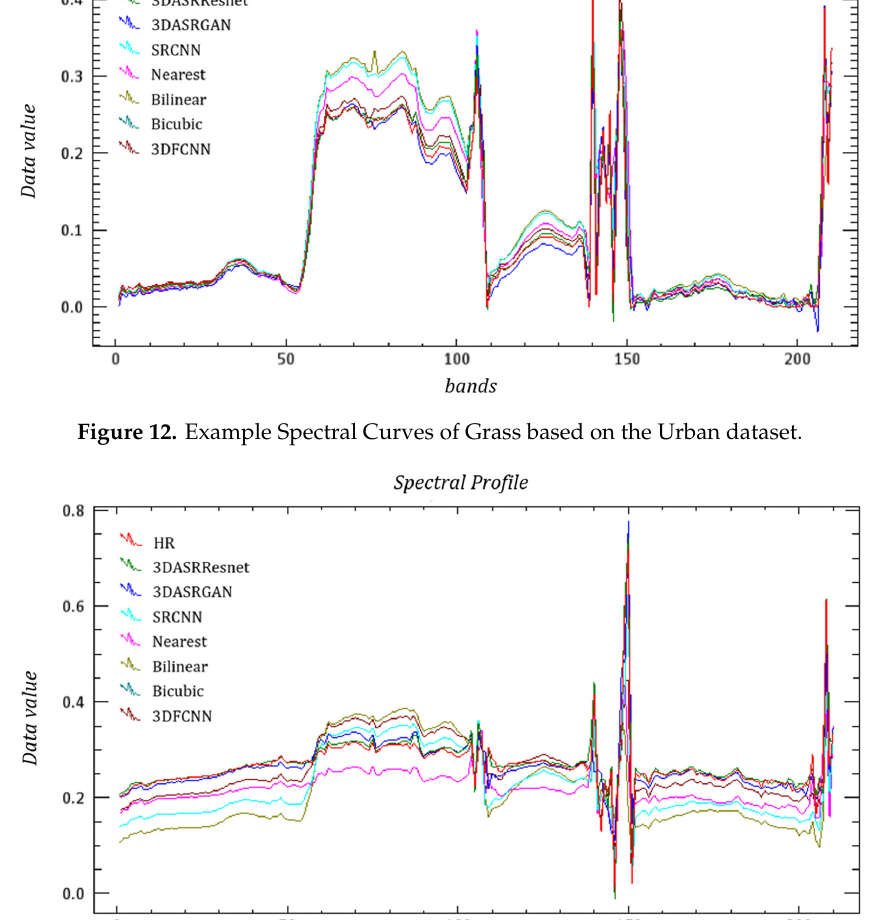
Figure 13. Example Spectral Curves of Roof based on the Urban dataset.